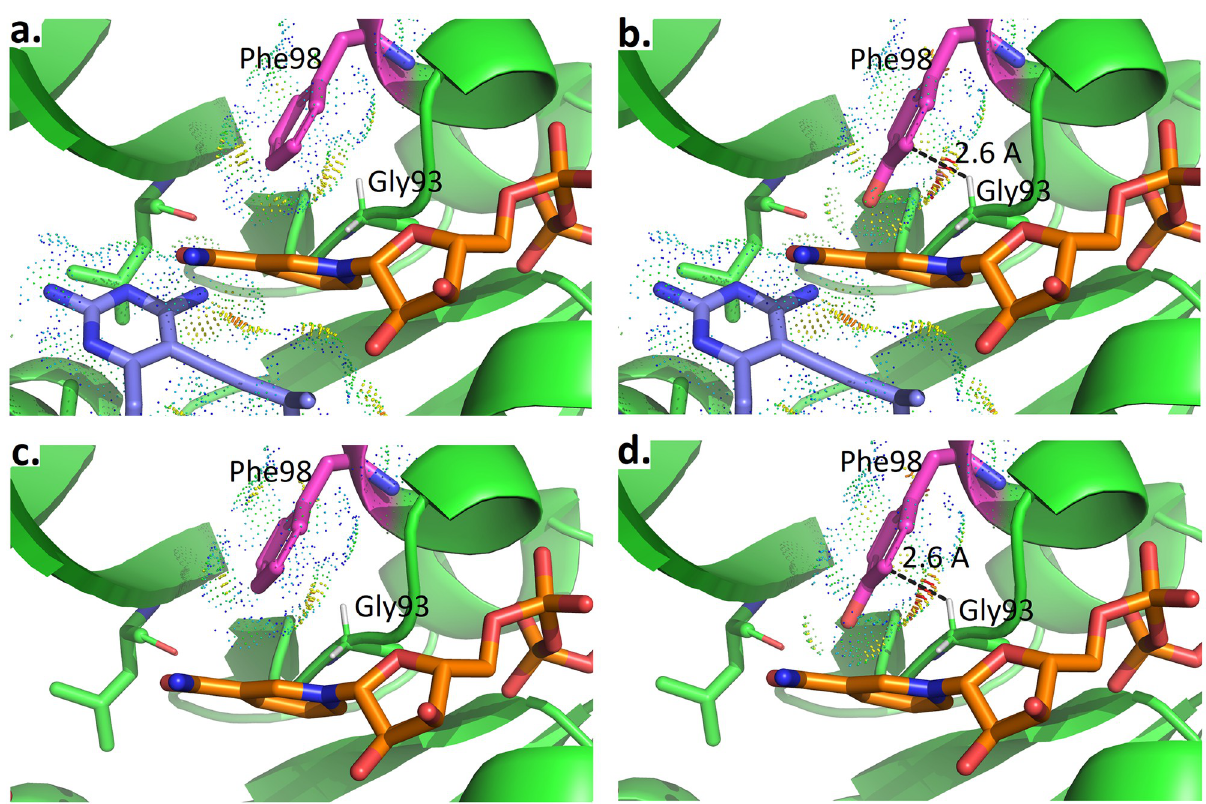
Fig 7. OSPREY -predicted low energy conformations for β -NADPH complexes. a. Ternary complex of S27: β -NADPH:DHFR(WT) b. Ternary complex of S27: β -NADPH:DHFR(F98Y) c. Binary complex of β -NADPH:DHFR(WT) d. Binary complex of β -NADPH:DHFR(F98Y).